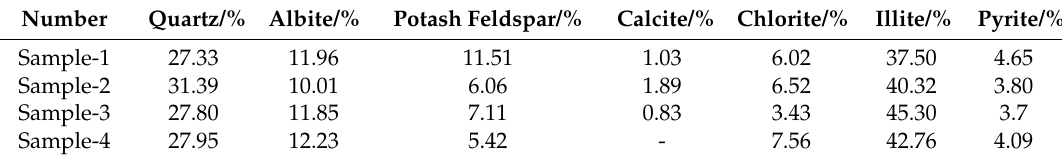
Table 1. Result of X-ray powder diffraction of Longmaxi shale from Shizhu Country (by Xu et al. [21]).